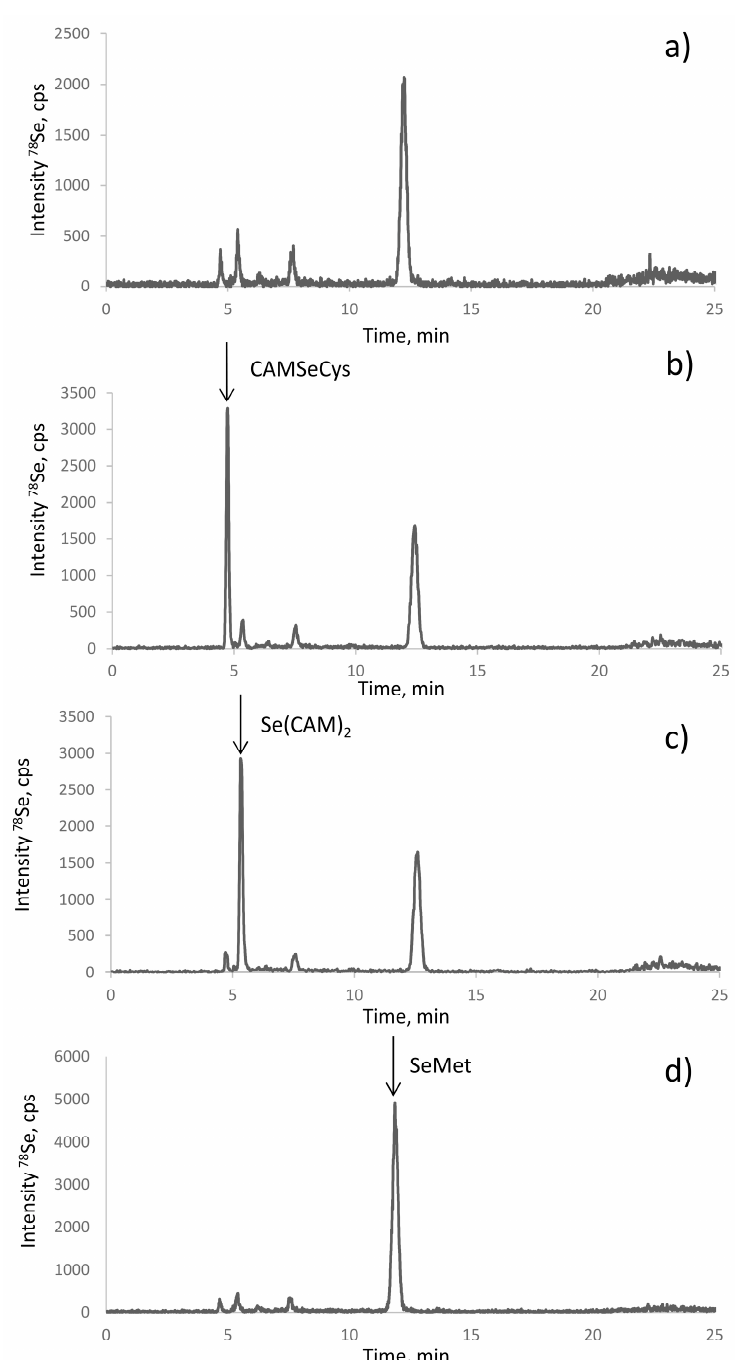
Figure 4. Identification of the species in the proteolytic digest of selenized yeast (SELM-1) ( a ) using spiking with standards of ( b ) CAM-SeCys, ( c ) Se(CAM) 2 , and ( d ) SeMet.